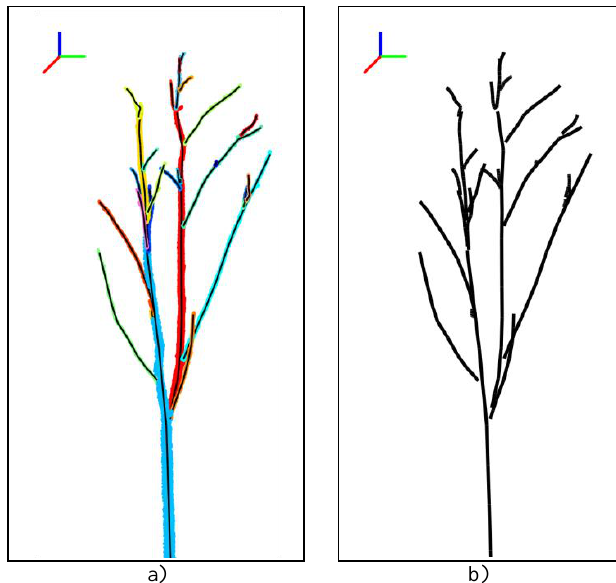
Figure 1. Results of our strategy to retrieve spatial structure: a) Segmented 3D point cloud; colors indicate group clusters. b) Skeletal structure according to segmentation.